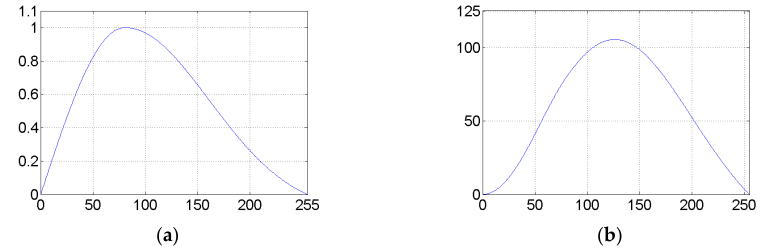
Figure 3. ( a ) Weight functions for the intensity value 0 to 255; ( b ) Adjustment value for the intensity value 0 to 255.